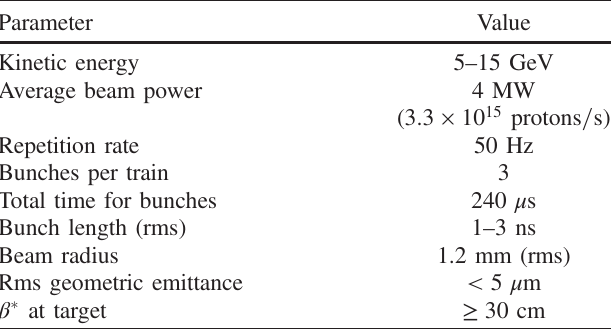
TABLE I. Proton driver requirements. A proton kinetic energy in the range 5 GeV to 15 GeV has been shown to provide adequate performance [21]. The number of protons, beam radius, β (cid:3) , and geometric emittance correspond to the values for an 8 GeV proton beam.